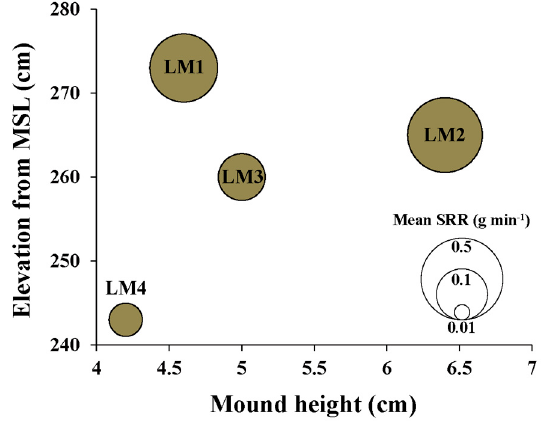
Figure 6. Correlation between mean SRR and mound height. Yellow, green, purple, and orange circles represent LM1, LM2, LM3, and LM4, respectively.